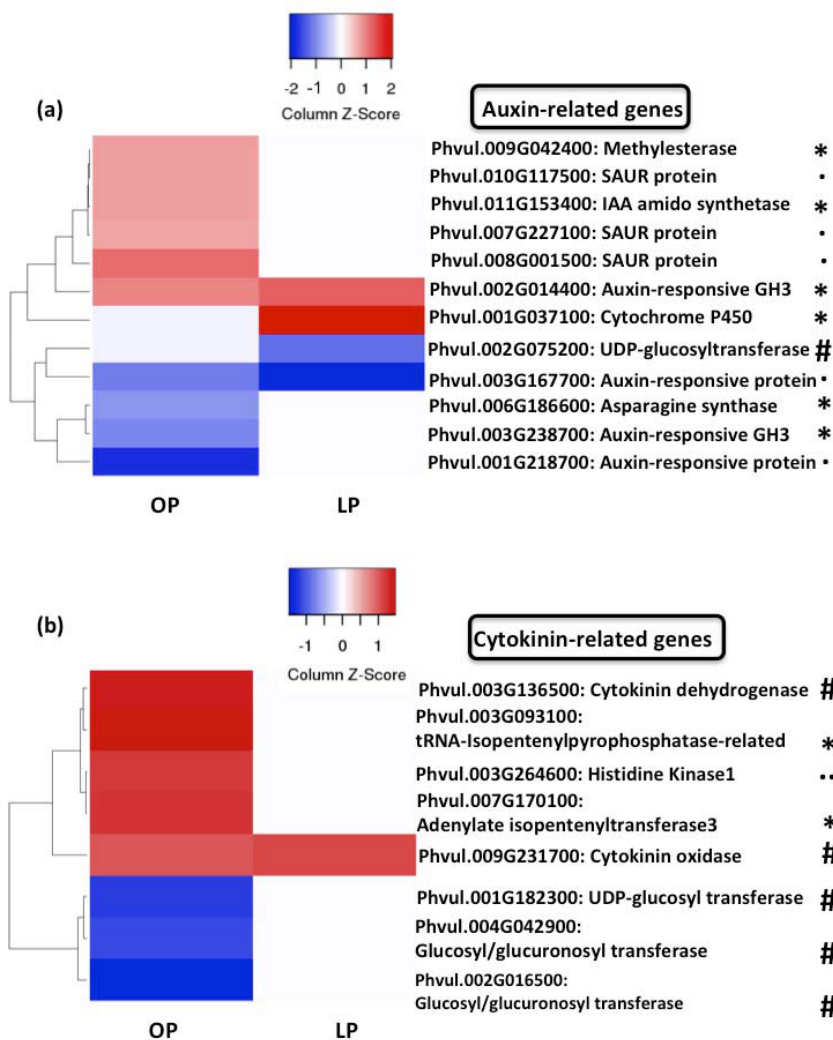
Figure 7. Pi deficiency affects the expression of rhizobia-induced auxin- and cytokinin-related genes. Heat-map showing the fold-change of genes involved in the biosynthesis (*), homeostasis (#), signal transduction (..) of auxin ( a ) or cytokinin ( b ) in common bean seedlings growing under OP or LP conditions and inoculated for 48 h with rhizobia. Genes regulated by auxins or cytokinin are indicated with (.). Fold-changes were false-colored. Genes showing higher expression are shown in different scales of red color, whereas genes showing lower expression were colored in blue color. Genes involved in biosynthesis.